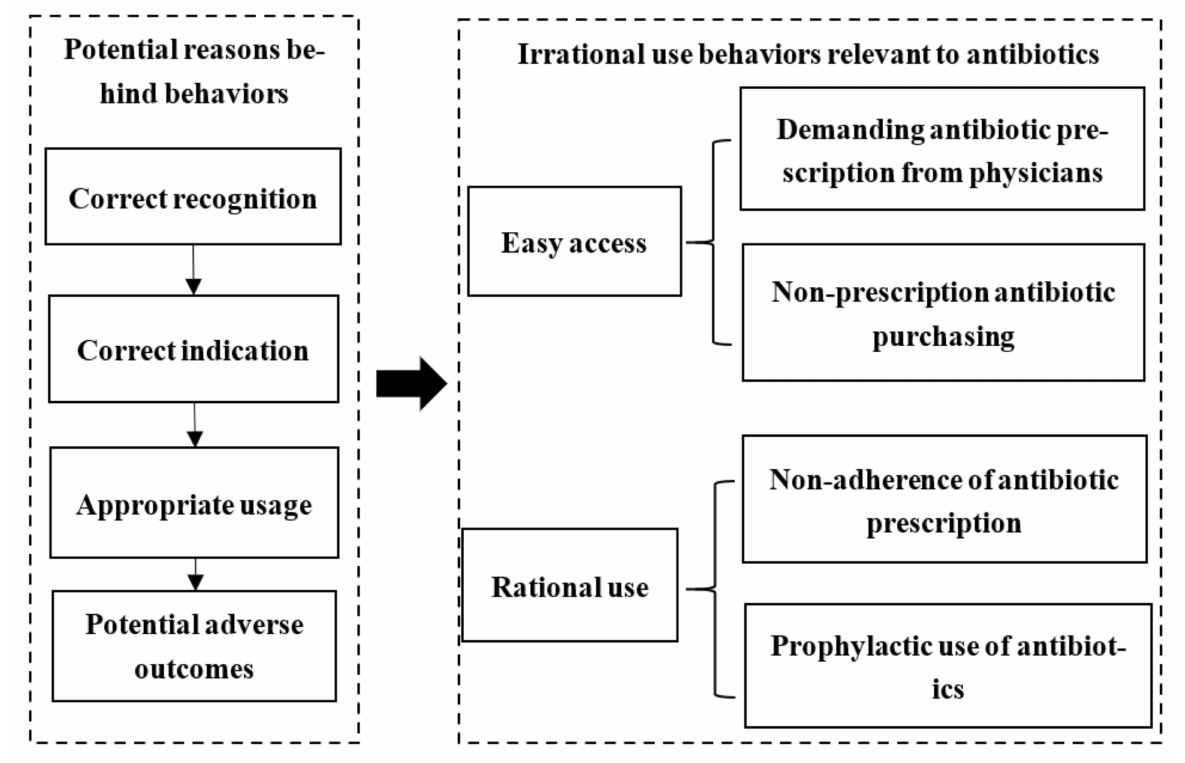
Figure 1. Review